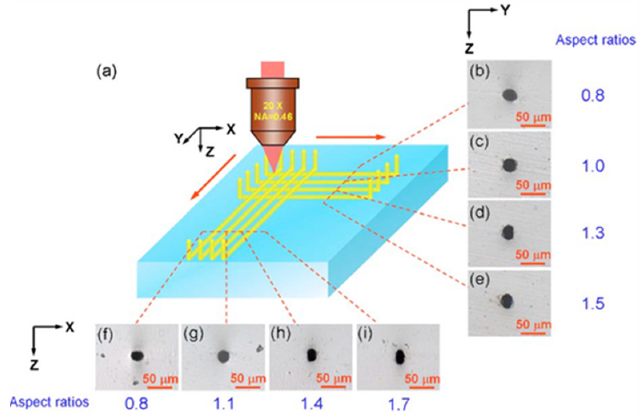
Figure 6. ( a ) Experimental setup of fabrication of microfluidic channel in glass using SSTF technique. The cross-sections of ( b – e ) x - and ( f – i ) y -oriented microfluidic channels. Reproduced with permission from [18], Copyright The Optical Society, 2010.